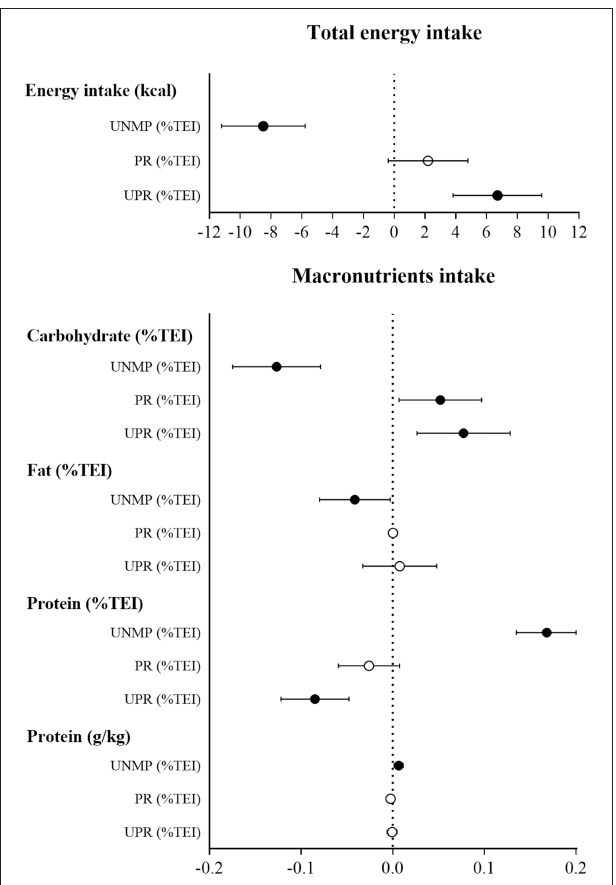
FIGURE 2 | Associations between macronutrient intake (dependent variables) and food consumption by processing level (independent variables). Data presented as standardized β (95% CI); • p < 0.05; ◦ p > 0.05. UNMP, unprocessed and minimally processed foods; PR, processed foods; UPR, ultraprocessed